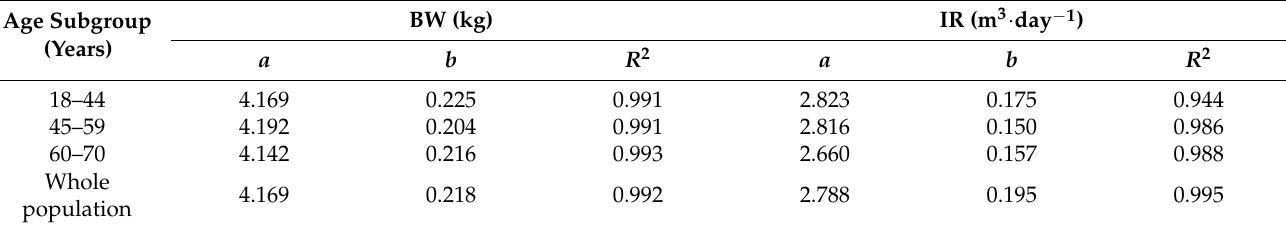
Figure 3. Fitting of exposure parameters in the risk assessment ( A ) BaP eq concentration, ( B ) inhalation rate of populations from different age groups, and ( C ) body weight of populations from different age groups. Table 2. Distribution of exposure parameters for Monte Carlo